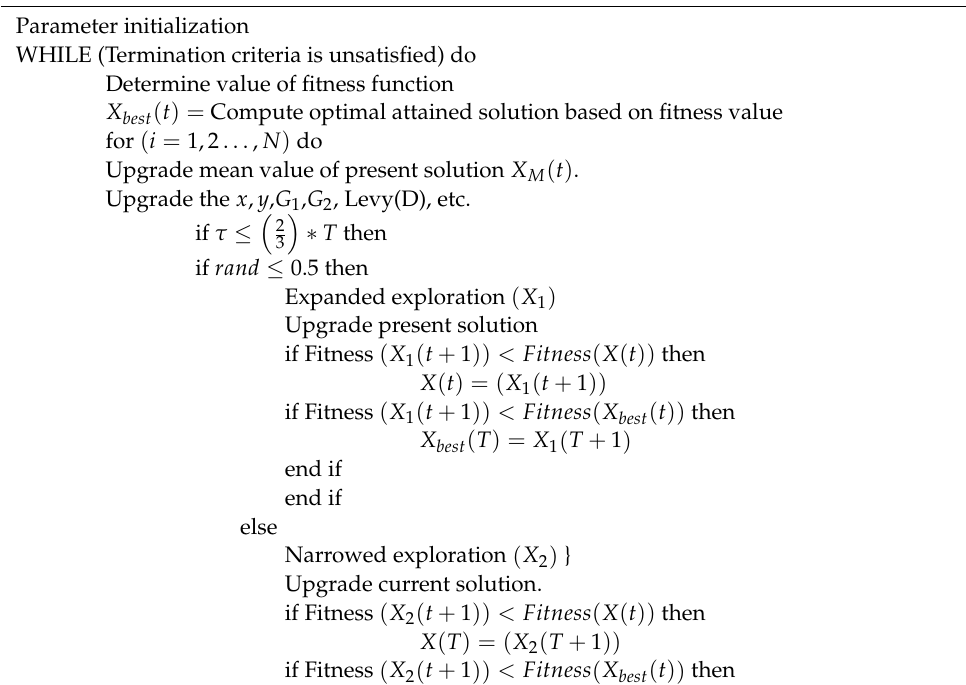
Algorithm 1: Pseudocode of AO